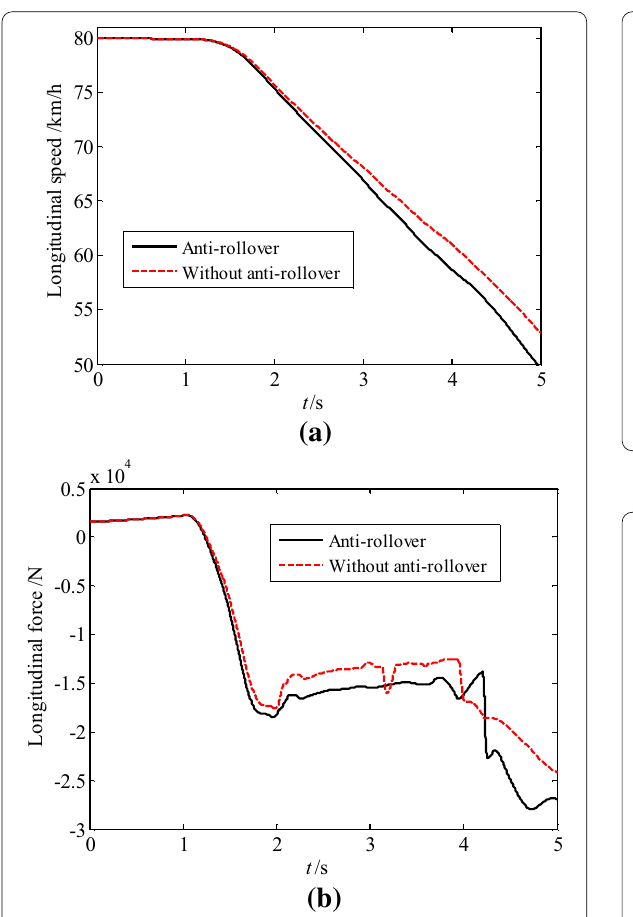
Figure 12 Longitudinal dynamics of the intelligent heavy truck in Scenario 2: ( a ) Longitudinal speed; ( b ) Longitudinal force